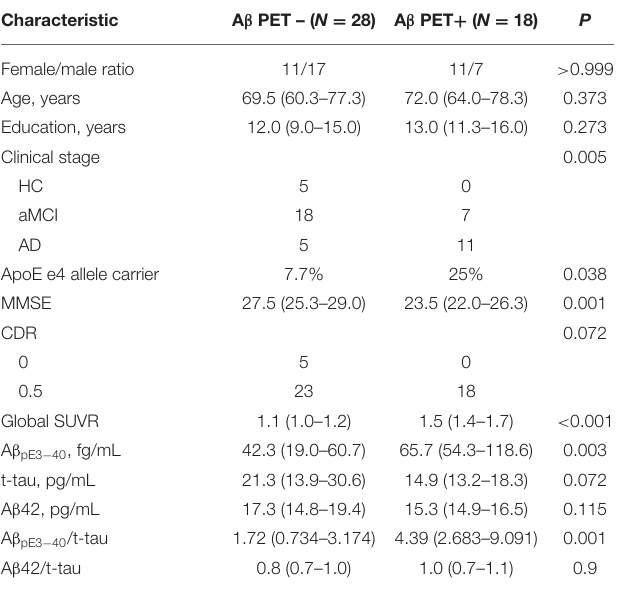
TABLE 1 | Demographic and clinical characteristics of enrolled subjects ( N =